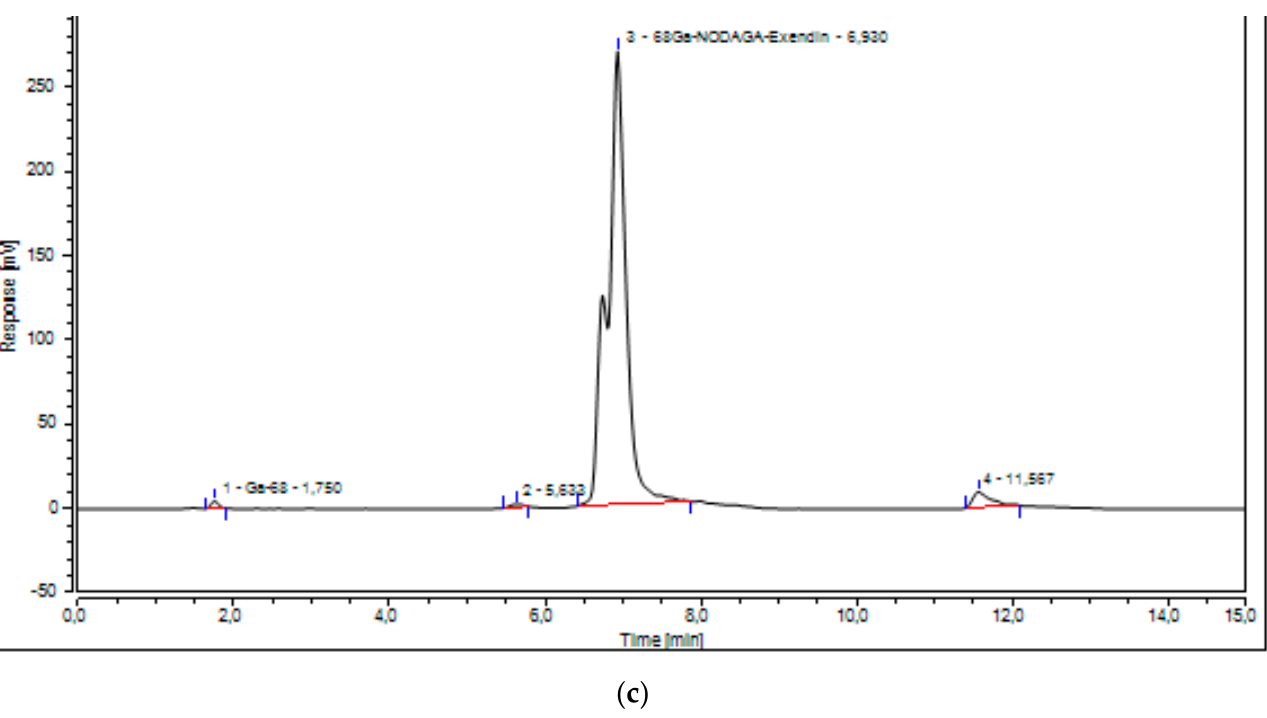
Figure 3. UV-Radio-HPLC chromatograms of [ 68 Ga]Ga-NODAGA-exendin-4 for all three validation batches ( a – c ). Pure and analytical grade eluents: 0.1% trifluoroacetic acid (TFA) in water